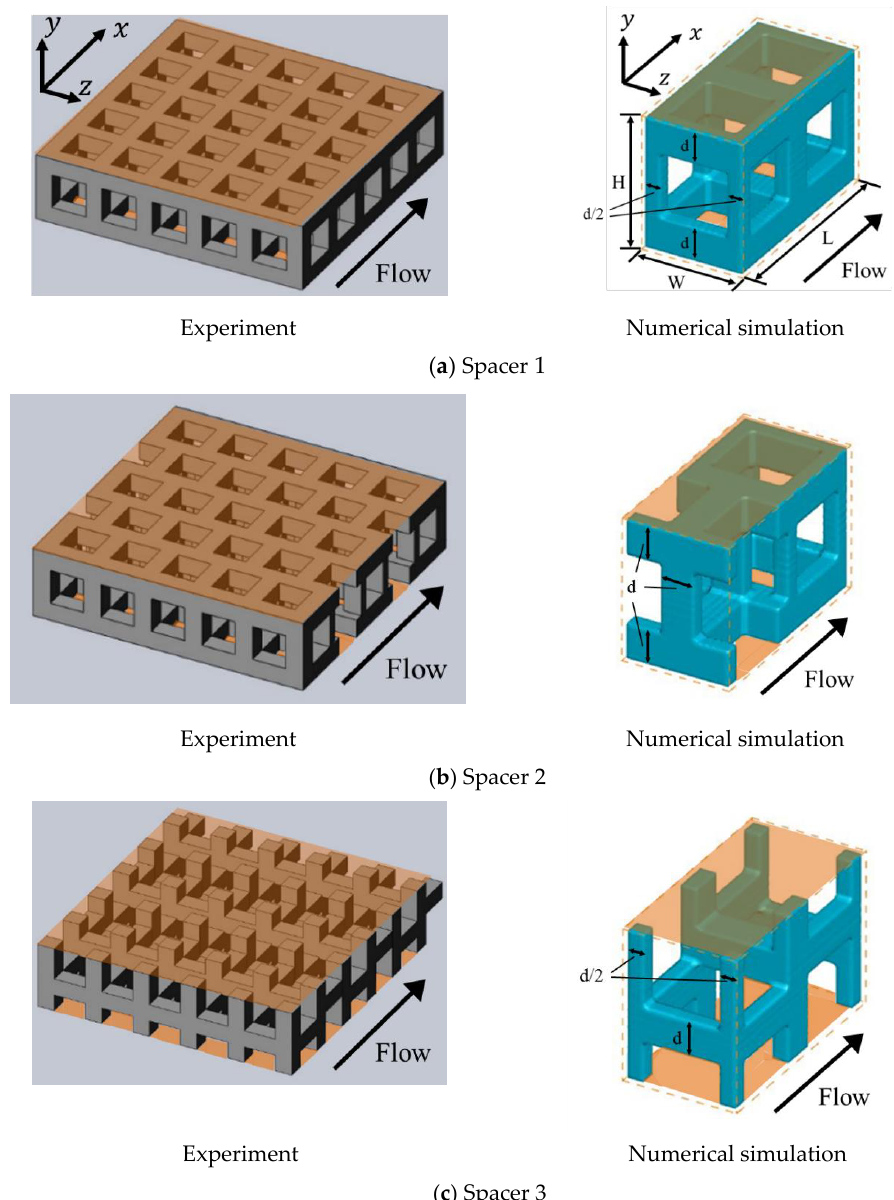
Figure 1. Porous spacer shapes. ( a ) Spacer 1 has a basic structure in which cubic lattices are simply combined with each other; ( b ) Spacers 2 has a staggered cubic lattice arrangement, which is shifted by a half lattice in the z direction relative to Spacer 1; ( c ) Spacers 3 has a staggered cubic lattice arrangement, which is shifted by a 1/3 lattice in the y direction relative to Spacer 1.